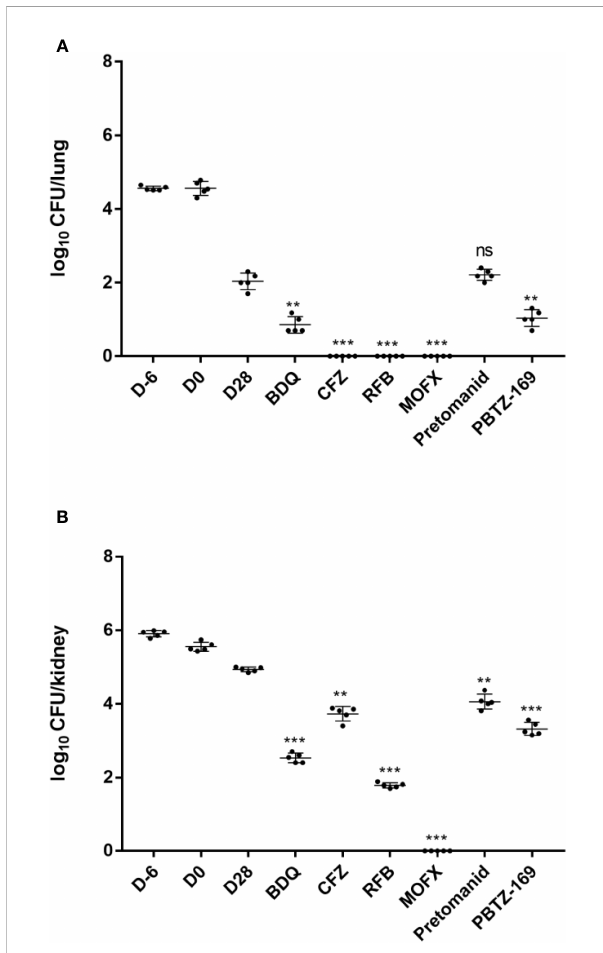
FIGURE 5 Mean number (log 10 ) of CFU per lung (A) and kidney (B) in various groups of mice infected with M. fortuitum . No mice experienced procedural failure or mortality. *P <0.05; **P <0.01; ***P